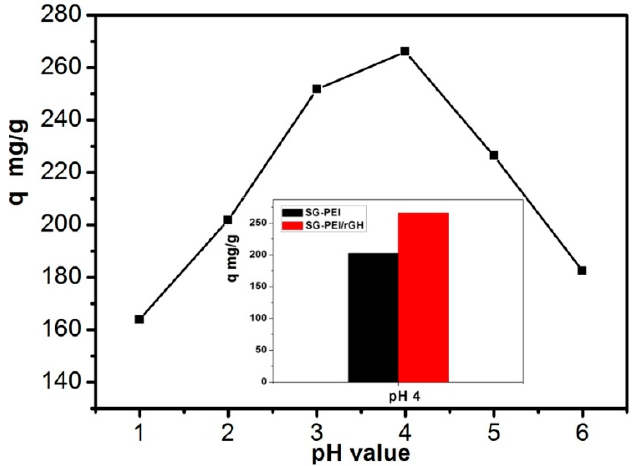
Figure 4. The effect of pH on adsorption capacity.